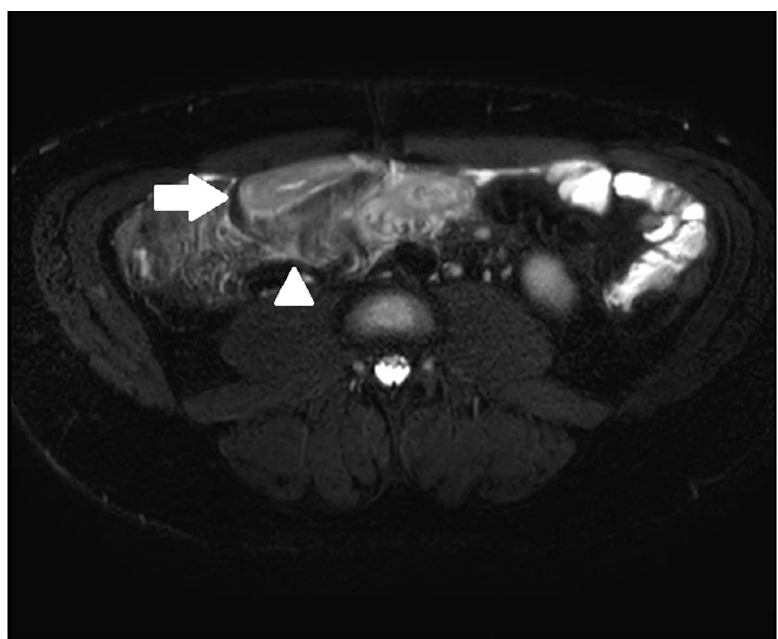
Figure 2. A 33-year-old male with ileal CD. Axial T2-weighted fat-saturated sequence demonstrating terminal ileal wall thickening and intra mural oedema (arrow) with peri enteric oedema (arrow ‐ head).